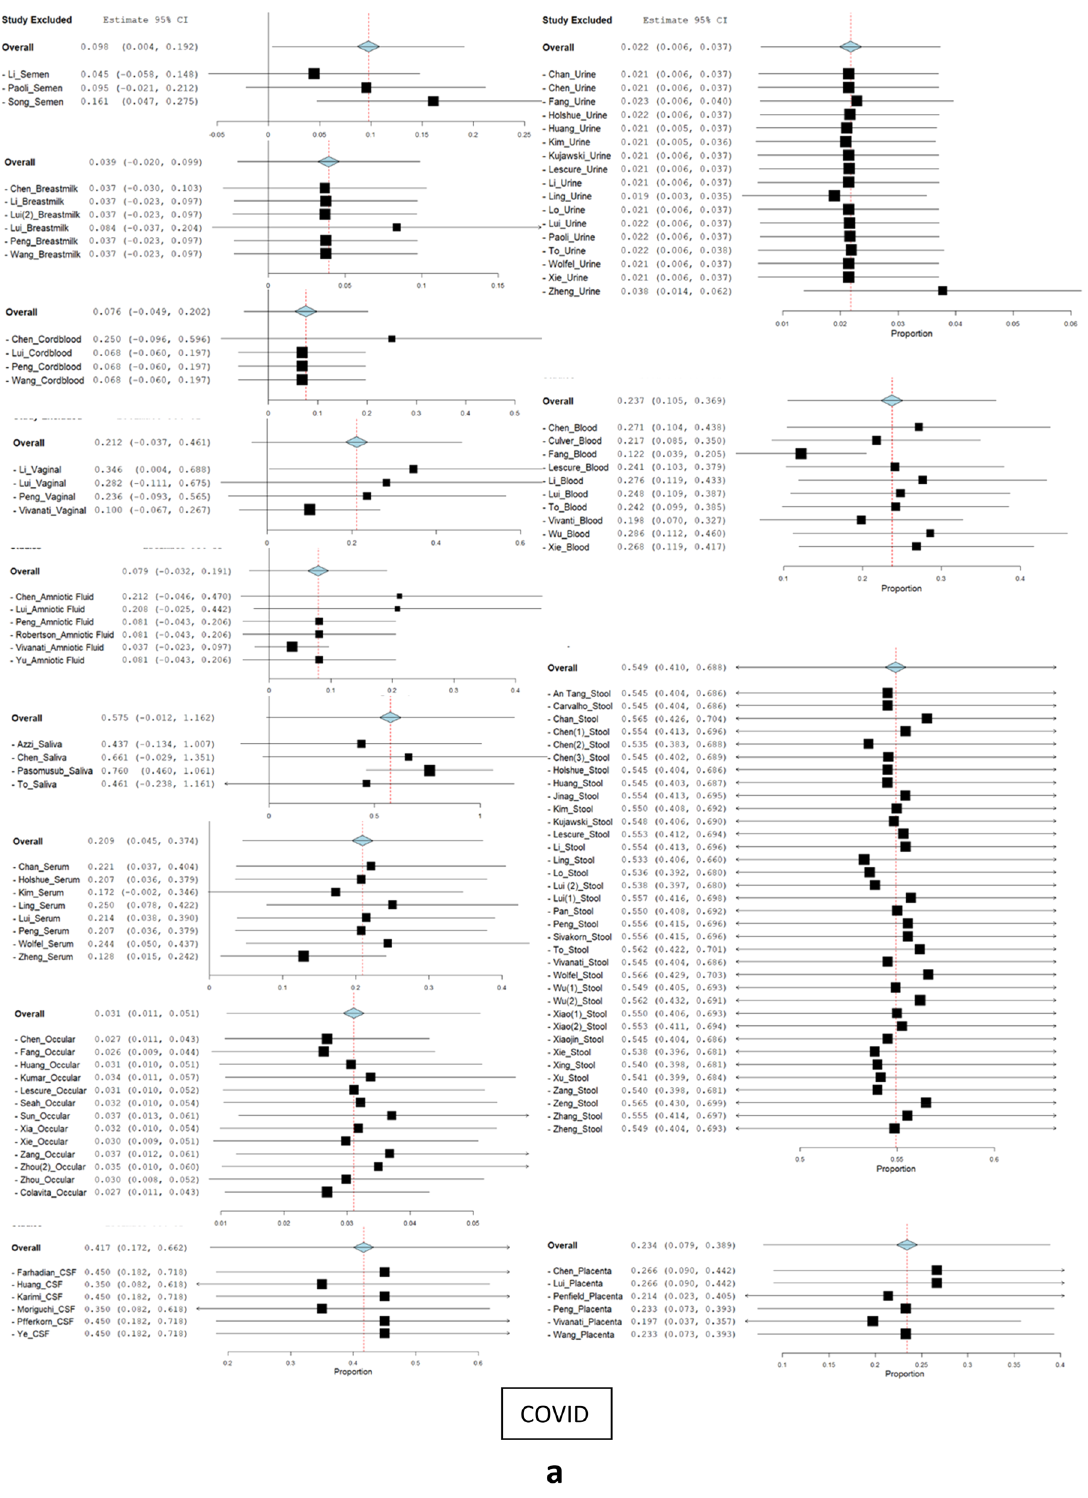
Figure 3. ( a ) Sensitivity analysis (leave one out) forest plot for COVID. ( b ) Sensitivity analysis (leave one out) forest plot for SARS and